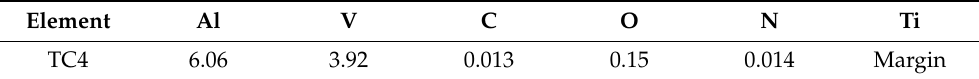
Table 1. Chemical composition of the TC4 titanium alloy (mass fraction, %). Element